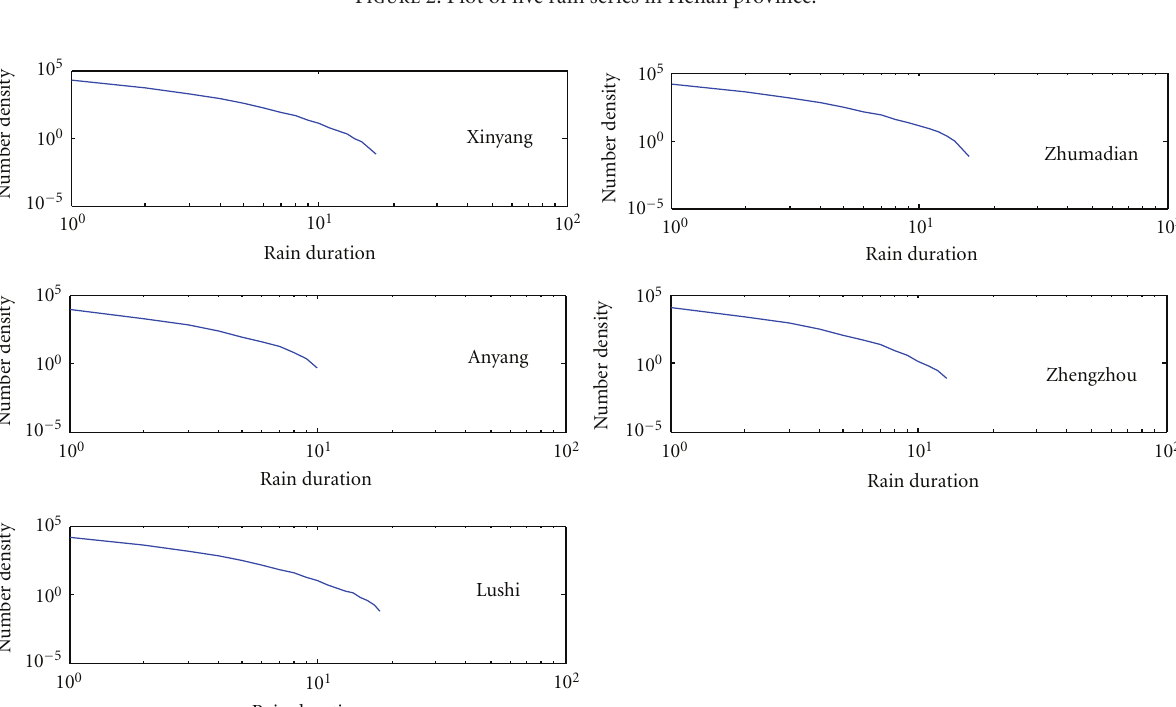
Figure 2: Plot of five rain series in Henan province.